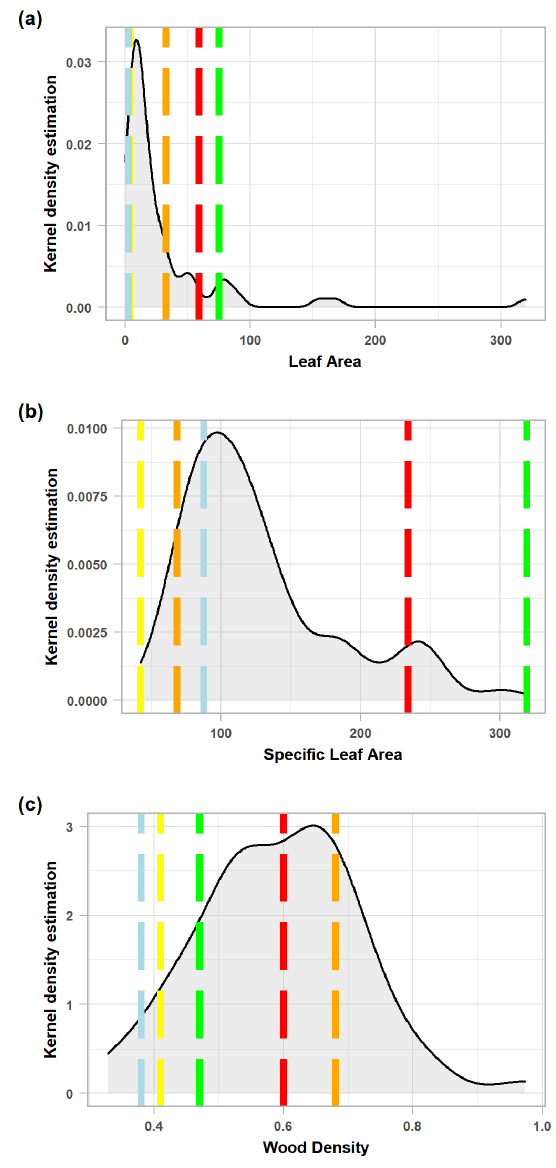
Figure 2. T raits Probability Density (TPD) of (a) leaf area (cm 2 ), (b) specific leaf area (cm 2 g -1 ) and (c) wood . density (g.cm -3 ) for a set of native tree species (black line) from the subtropical mixed forest in southern Brazil. Vertical dashed lines indicate mean traits values for the non-native invasive tree species (red = Hovenia dulcis; orange = Ligustrum lucidum; green = Morus nigra; yellow = Pinus elliotti; blue = Pinus taeda